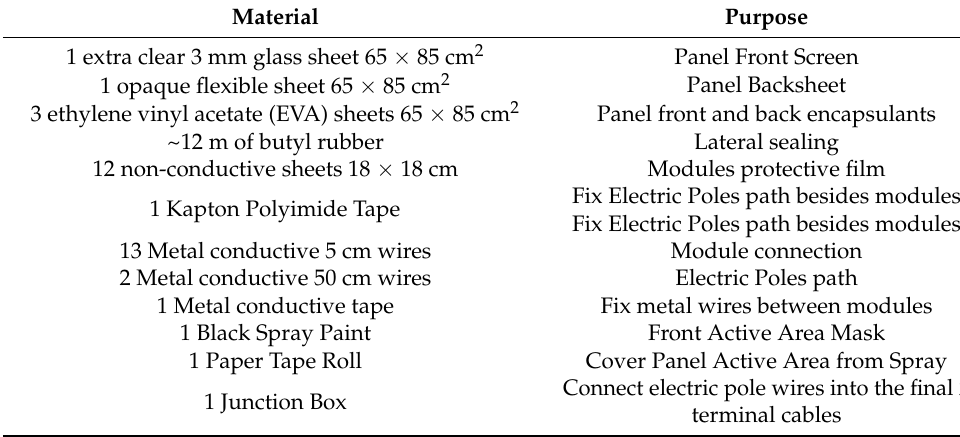
Table 3. List of additional materials needed for panel